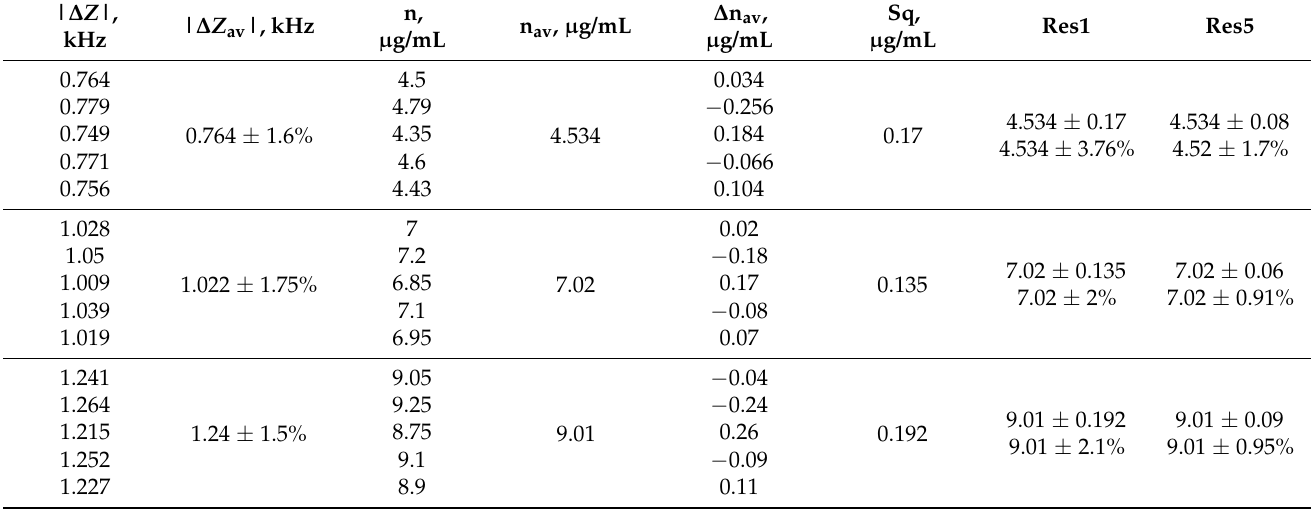
Table 1. The results of the independent experiments for the measurement of chloramphenicol concen- tration using a calibration curve in Figure 5b. We have introduced the following designations: | ∆ Z | is the module of the impedance of the resonator; | ∆ Z av | is the averaged module of the impedance of the resonator; n is the CAP concentration; n av is the averaged value of CAP concentration; ∆ n av is the deviation from n av ; Sq is the squared error of one measurement; Res1 is the result of one measurement; Res5 is the result of five